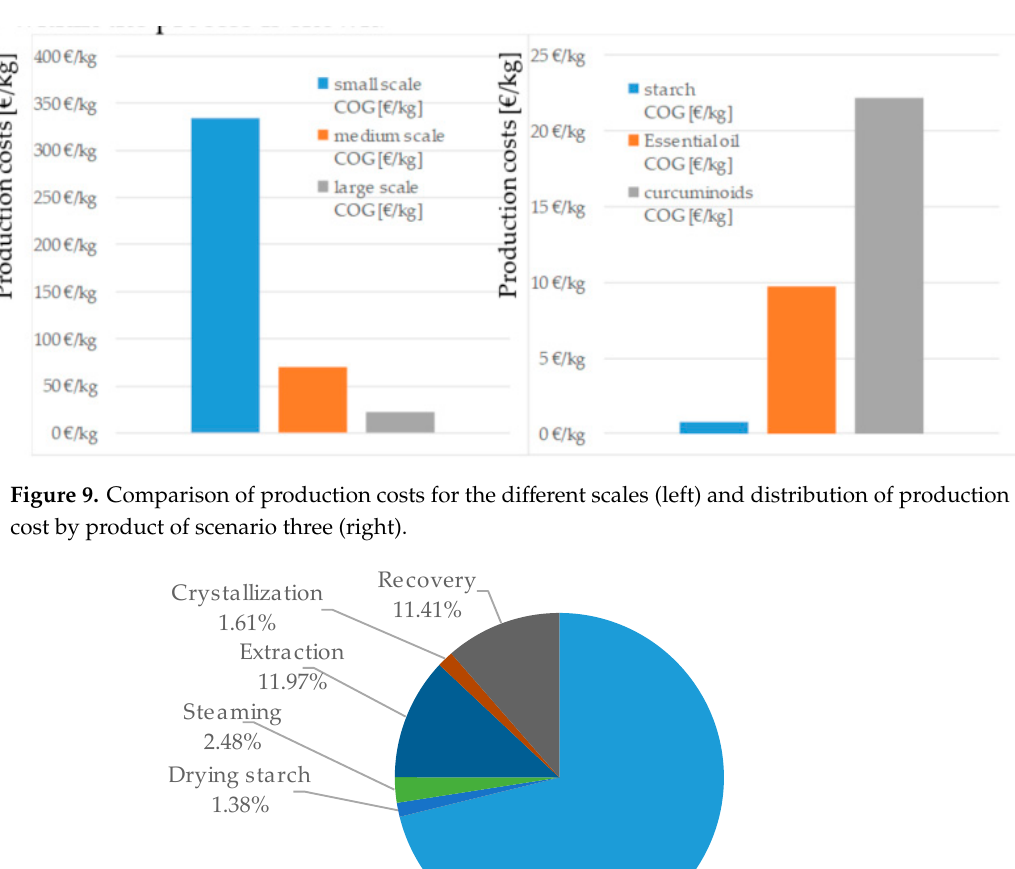
Figure 9. Comparison of production costs for the different scales (left) and distribution of production cost by product of scenario three (right).